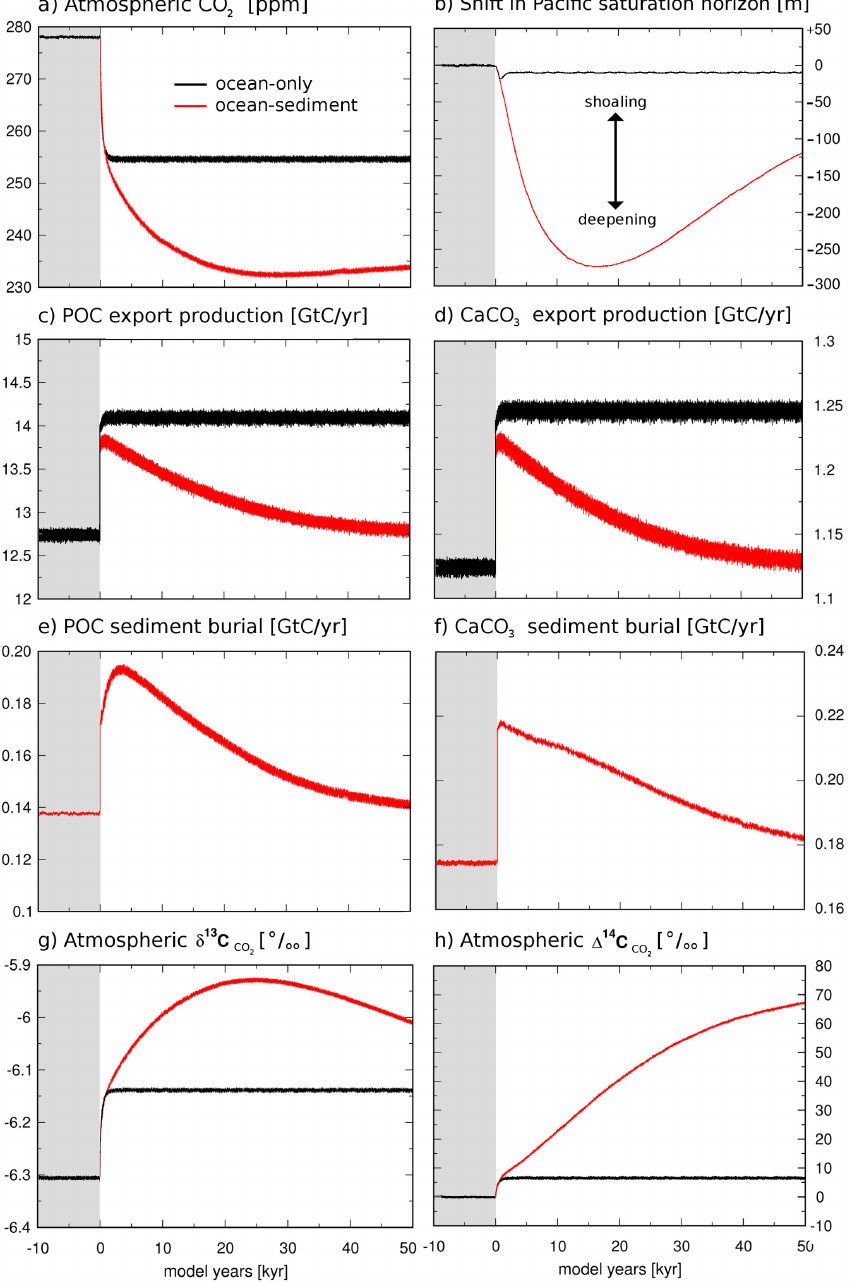
Fig. 4. Strengthening of the marine biological cycle: Simulated response to an abrupt 30%-increase in the ocean’s phosphate content. (a) Atmospheric CO 2 , (b) shift in Pacific CaCO 3 saturation horizon, (c) POC export production, (d) CaCO 3 export production, (e) POC sedimentation, (f) CaCO 3 sedimentation, (g) atmospheric δ 13 C CO